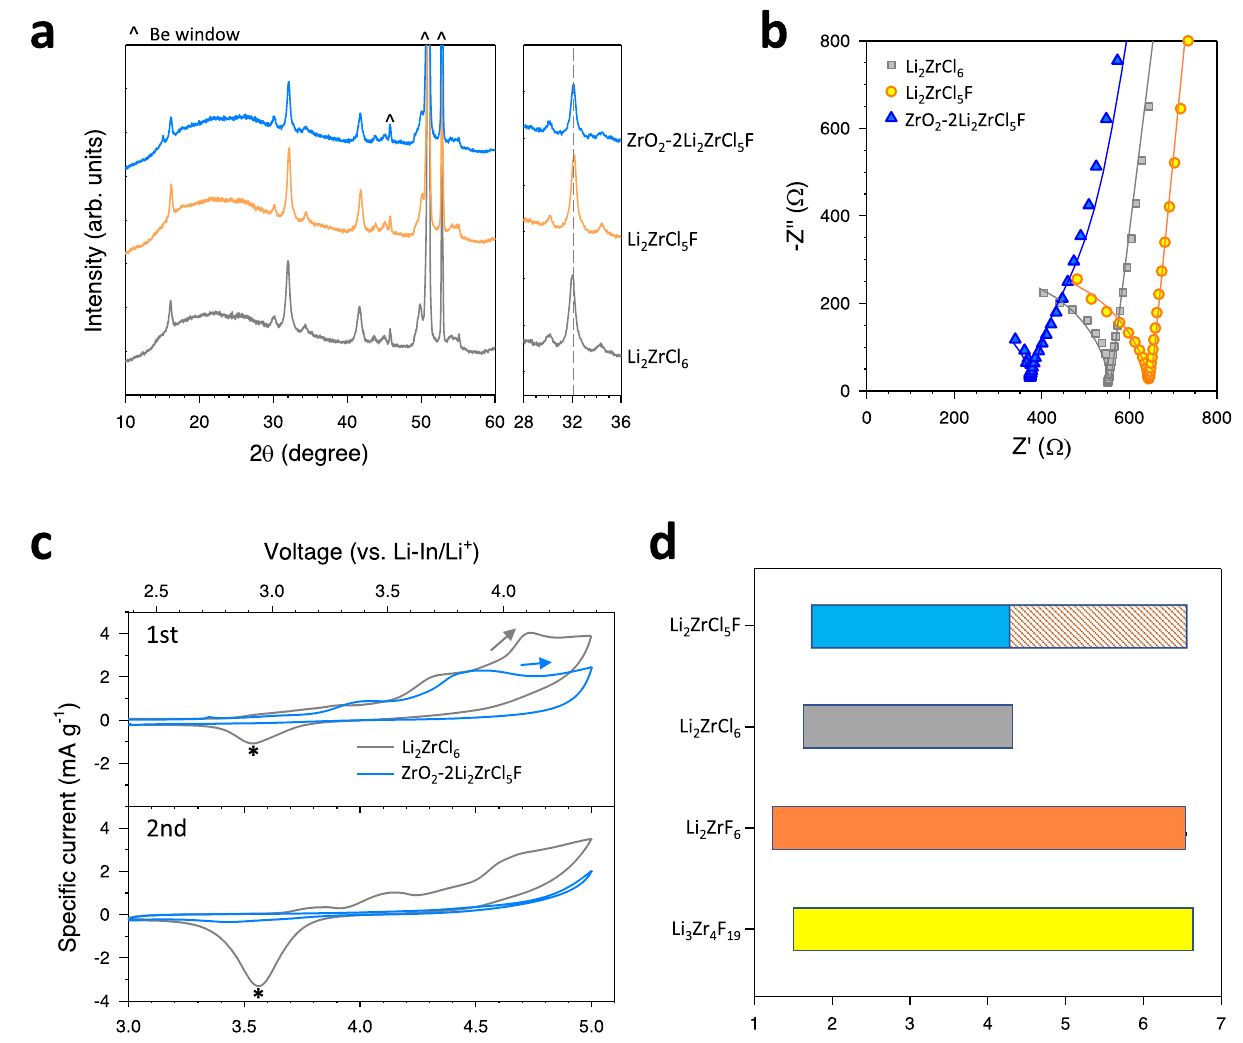
Fig. 4 | HNSE for F-substituted Li 2 ZrCl 6 (ZrO 2 -2Li 2 ZrCl 5 F). a – c XRD patterns ( a ) and Nyquist plots of Ti|SE|Ti symmetric cells ( b ) for Li 2 ZrCl 6 , Li 2 ZrCl 5 F, and ZrO 2 - 2Li 2 ZrCl 5 F. The fi tted lines are also plotted in ( b ). The symbols represent the raw data, and the lines correspond to the fi tted results obtained from the equivalent circuit model, as described in Supplementary Fig. 10. c CV curves for (SE-C)|SE| LPSCl|(Li-In) cells between 3.0 and 5.0V (vs. Li/Li + ) at 0.1mVs − 1 and